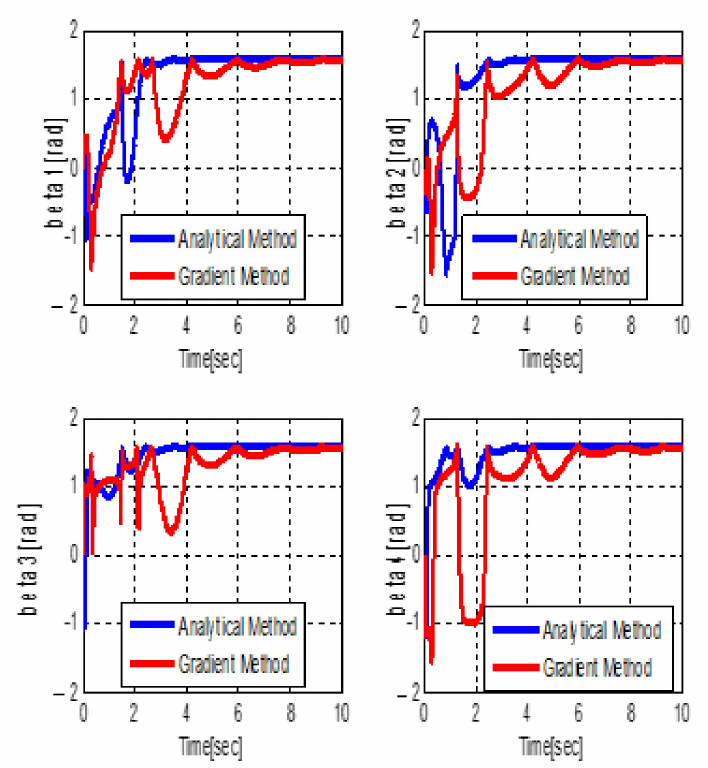
Figure 11. Swing angles of the propellers.